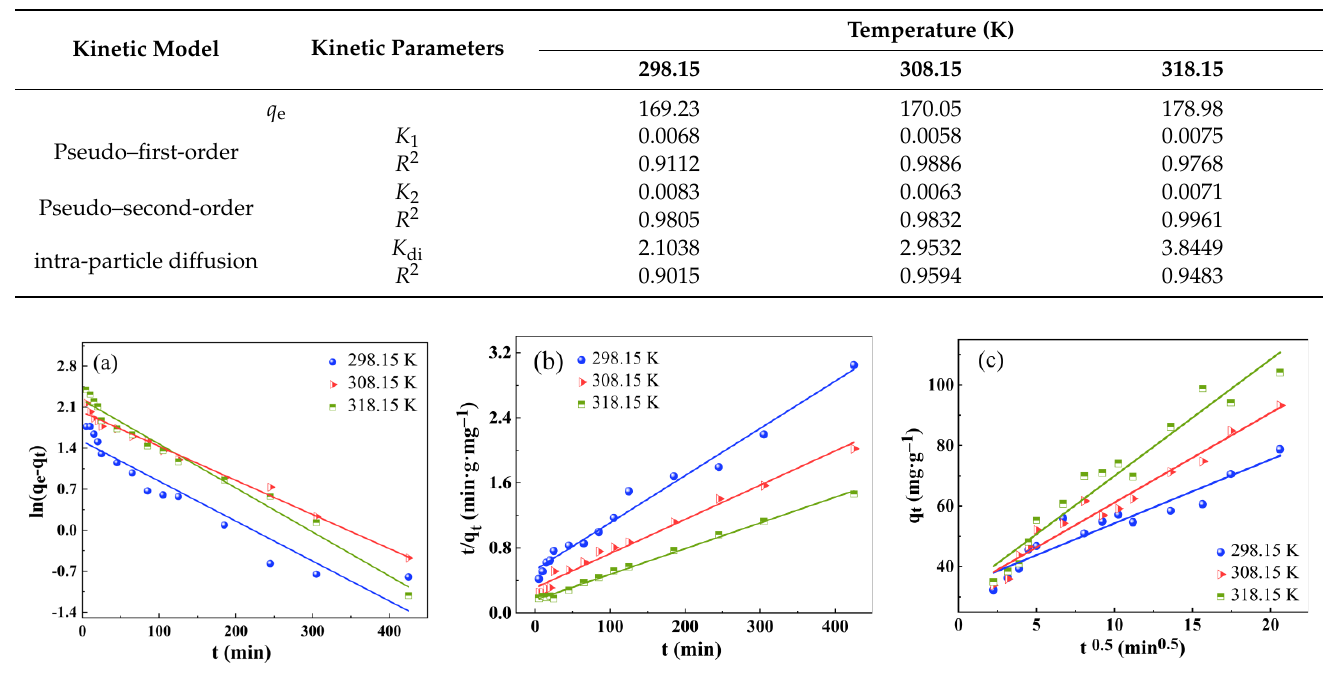
Figure 14. Adsorption kinetics of RhB adsorbed by hydrophobic ZrO 2 -SiO 2 xerogel: ( a ) pseudo–first-order kinetic plots, ( b ) pseudo–second-order kinetic plots, and ( c ) intra-particle diffusion plots (dosage = 0.05 g, pH = 3, RhB concentration = 140 mg · L − 1 , contact time = 120 min, T = 298.15, 308.15, and 318.15